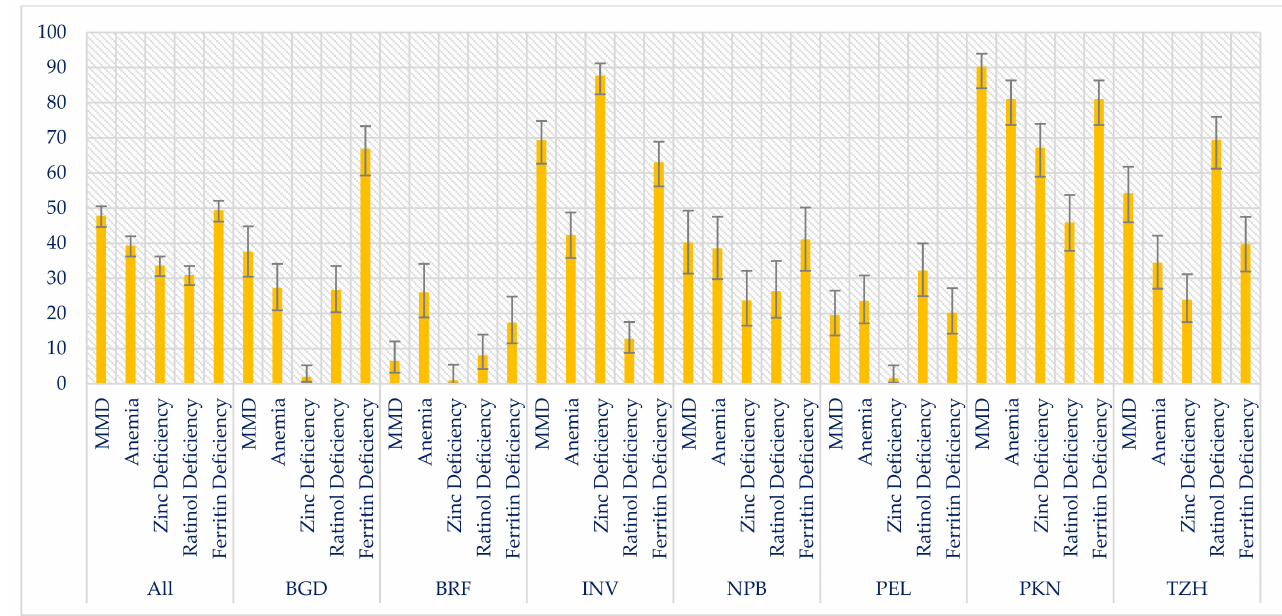
Figure 2. Prevalence of multiple micronutrient deficiencies, overall and by MAL-ED study